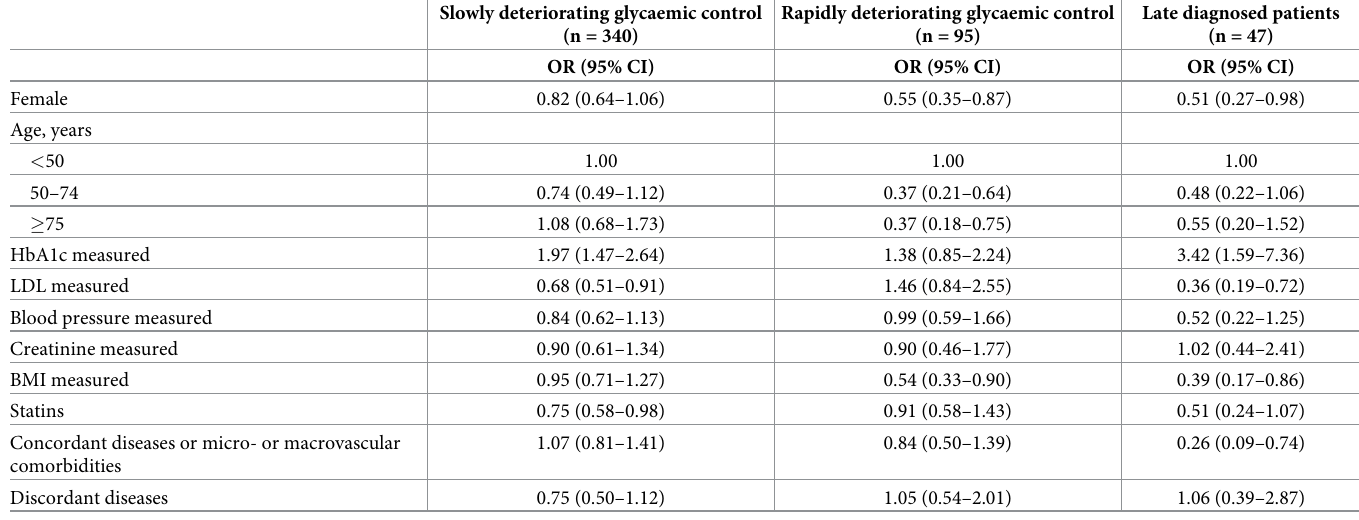
Table 2. Adjusted, multivariate odds ratios (95% confidence intervals) for the association of baseline characteristics with estimated trajectories (n = 1540). Stable, adequate glycaemic control trajectory (n = 1058) as a reference.